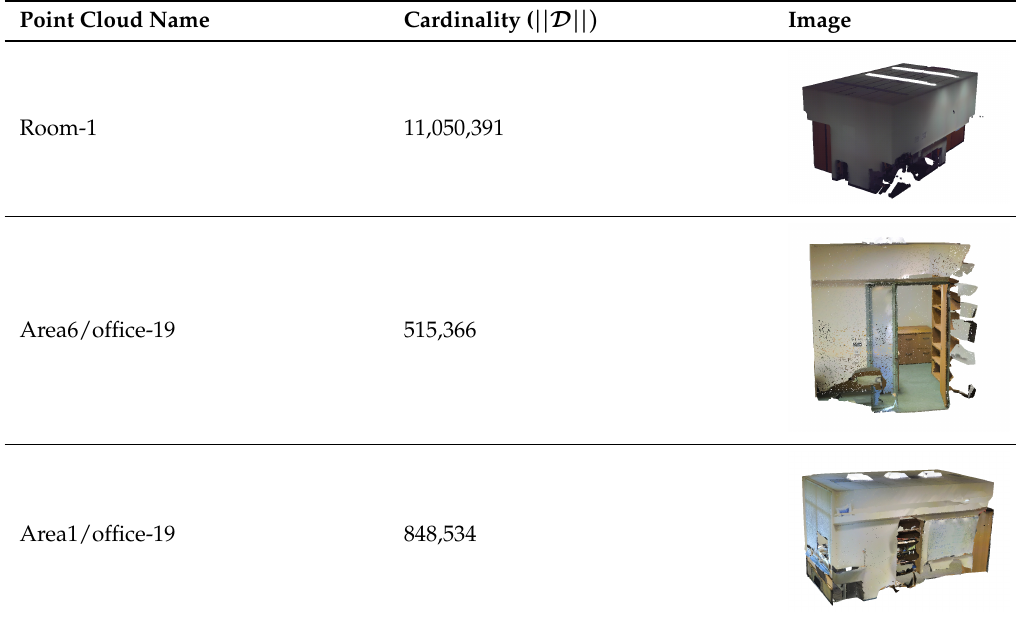
Table 2. Visualization of randomly selected six point clouds from tested S3DIS dataset plus additional Room-1 used by Li et